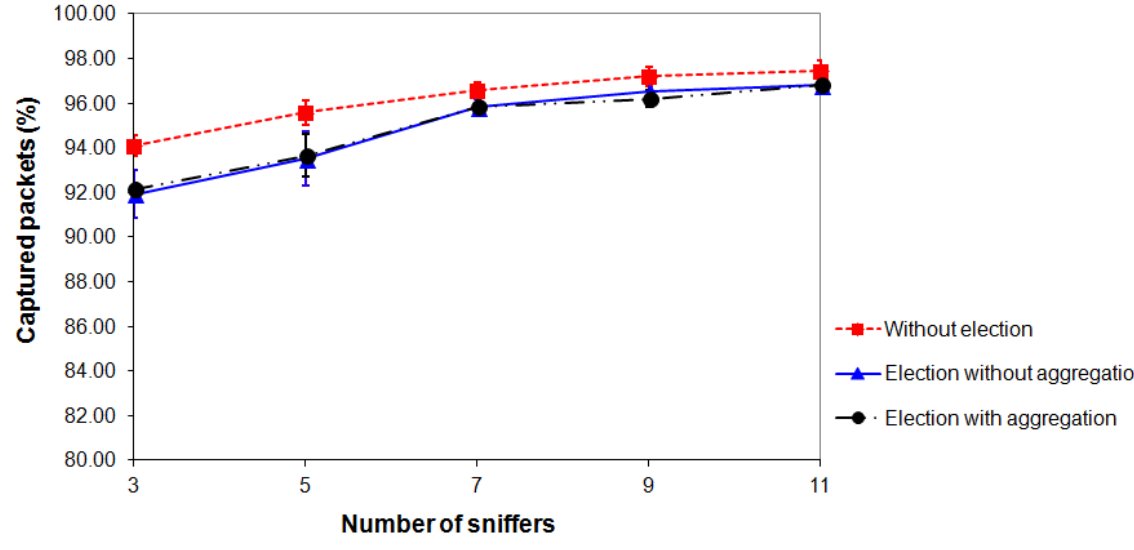
Figure 15. Packets captured by the monitoring network vs . number of